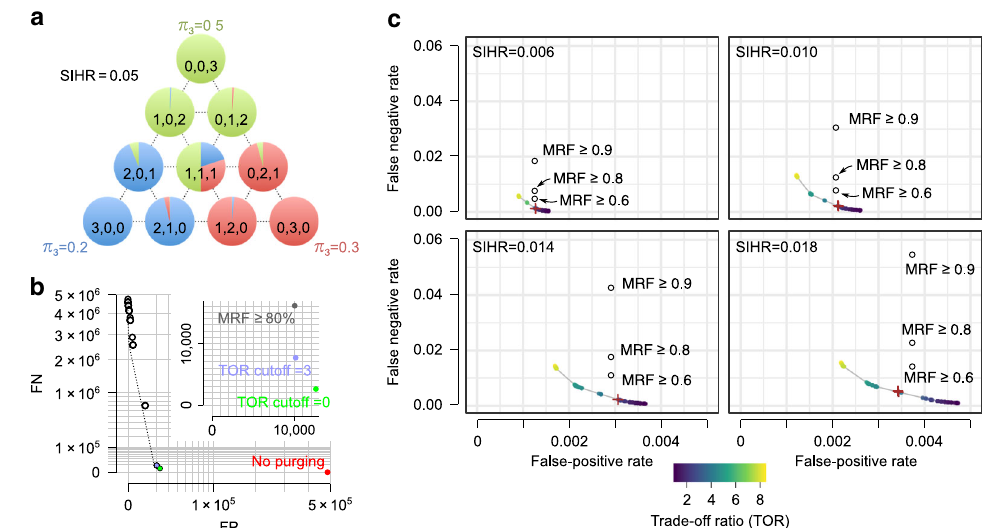
Fig. 3 Identi fi cation and purging of index-hopping artifacts. a A toy example, depicting the simplex containing all ten possible read count outcomes at PCR ampli fi cation level ( r = 3) and for the case of three samples (see also Supplementary Fig. 8). The pie charts depict the posterior probabilities of the true sample of origin for each outcome. π 3 represents the proportion of molecules with r = 3 that originate from each sample in this toy example. See “ Methods ” for derivation of the posterior probabilities. b Performance on a multiplexed dataset of two libraries with known ground truth (same dataset as Fig. 1c, d). Each dot represents the FN/FP counts, based on the ground truth, at different posterior probability cutoffs. The dashed line represents the model-based estimation of FP/FN. The no purging dot represents the total number of phantom molecules in the uncorrected multiplexed dataset (red dot). The inset shows a zoomed-in view of the graph for posterior probability cutoffs that correspond to trade-off ratio (TOR) cutoffs values of 0 and 3, in addition to a previous heuristic approach 6 that is based on retaining CUGs with a certain fraction of reads assigned to only one sample. c Performance on simulated data. The colored dots represent FP and FN proportions for distinguishing true molecules from phantom molecules, after fi ltering at different posterior probability cutoffs. The color of each dot represents the trade-off ratio (TOR), i.e., the number of real molecules lost for every extra phantom molecule that is correctly purged. The point that corresponds to TOR cutoff = 3 is marked with a plus. The simulations were performed for four evenly spaced values of SIHR (sample index-hopping rate). The open circles show the FN/FP values obtained by the heuristic approach 6 with three choices of the minimum read fraction (MRF) threshold: 0.6, 0.8, and